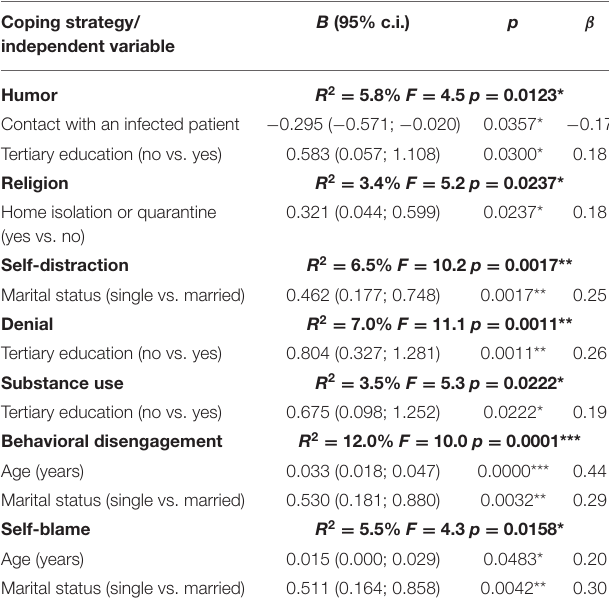
TABLE 10 | Use of active coping strategies to manage stress depending on the country and quarantine (or isolation). Independent variables